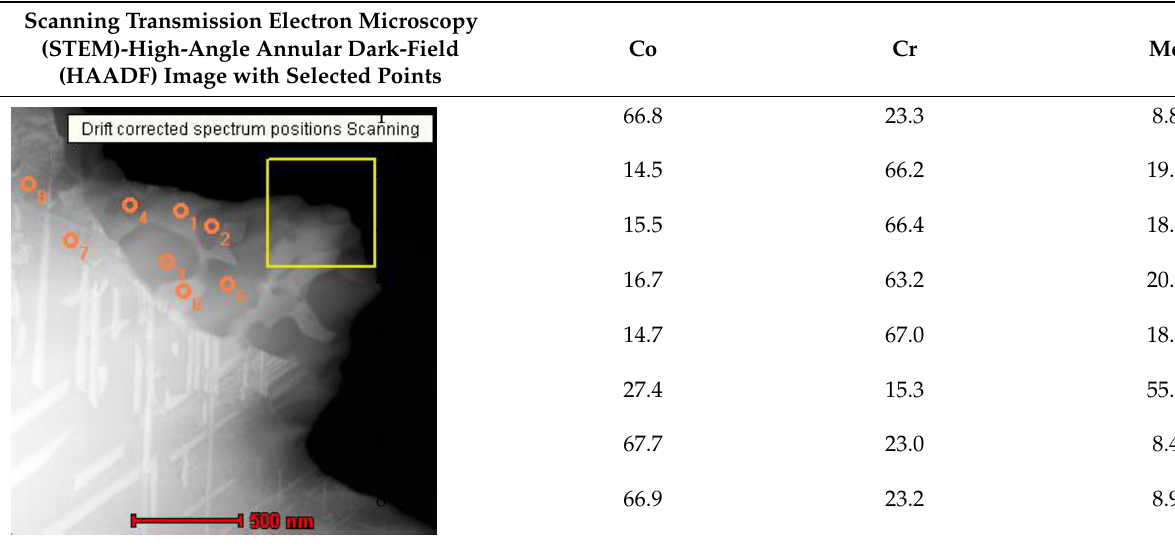
Table 4. Chemical composition of different phases of the cast Co-Cr-Mo alloy determined by TEM-EDS.